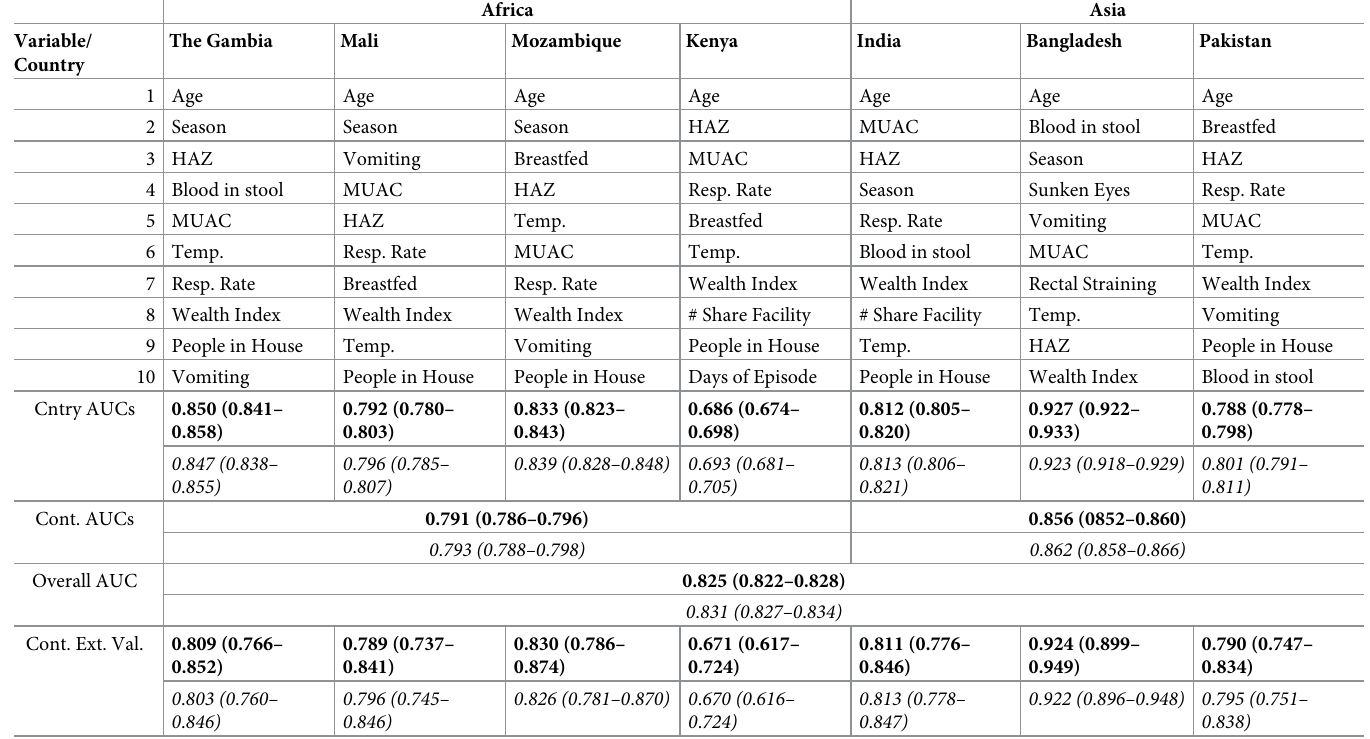
Table 4. The table contains both site-specific variable importance ordering and a cross-validated average overall AUC, AUC by country, and AUC by continent and confidence intervals from a 5 (bold) and 10 (ital.) variable logistic regression model for predicting a viral etiology with variables based on the overall variable impor- tance. Lastly, it shows the AUC and a 95% confidence interval resulting from testing the logistic regression with variables based on the overall variable importance on each site individually following its training on the other countries in the same